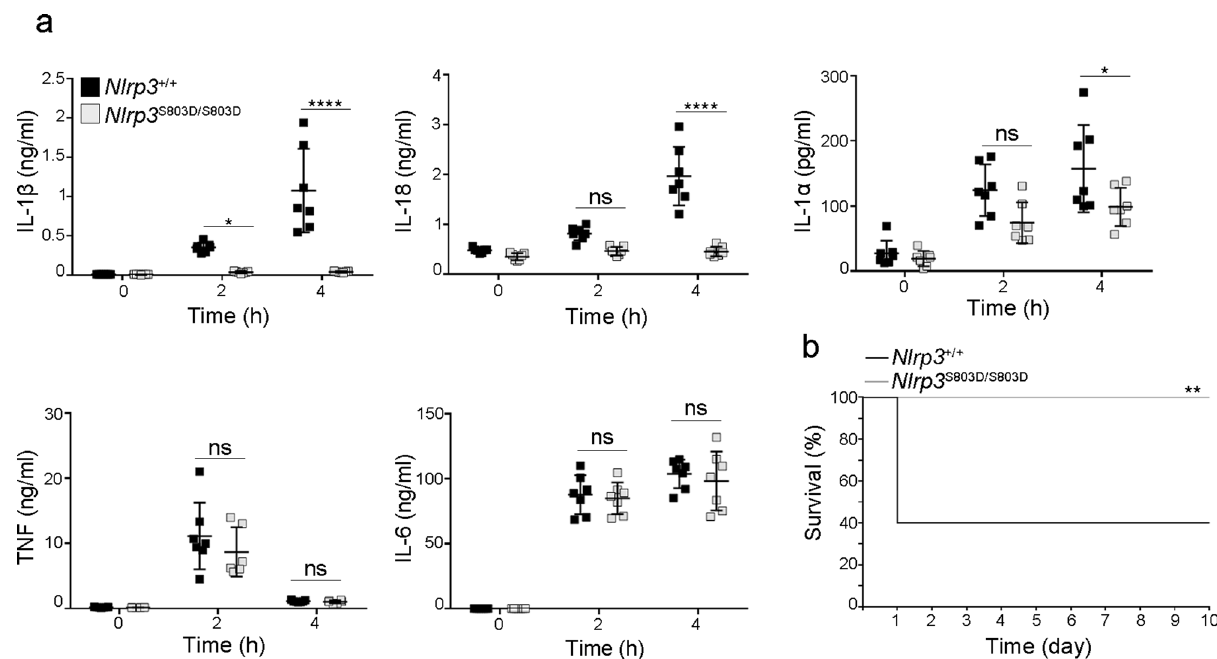
Fig. 5 S803D phospho-mimetic mutation blocks NEK7 recruitment by NLRP3. a Endogenous NEK7 immunoprecipitates from LPS-primed BMDMs treated with nigericin (30min) were analyzed for NLRP3 ( Nlrp3 + / + + beads, Nlrp3 + / + BMDM lysate incubated with A/G-beads without anti-NEK7). b NLRP3- de fi cient U937 cells reconstituted with NLRP3 mutants were treated with PMA, doxycycline, LPS, and nigericin. Endogenous NEK7 immunoprecipitates were analyzed for NLRP3 (WT + IgG, lysate of U937 expressing WT NLRP3 incubated with isotype control and A/G-beads). c , d BMDMs were treated with LPS (6h) and nigericin (30min). Endogenous BRCC3 immunoprecipitates were analyzed for NLRP3 ( Nlrp3 + / + + IgG, BMDM lysate incubated with IgG isotype control and A-beads; Brcc3 − / − , BRCC3 immunoprecipitates from Brcc3 − / − BMDM lysate) ( c ). NLRP3 ubiquitination was assessed by NLRP3 immunoprecipitation followed by anti-Ub WB ( Nlrp3 + / + + beads, Nlrp3 + / + BMDM lysate incubated with A/G-beads without anti-NLRP3) ( d ). e NLRP3- de fi cient U937 cells reconstituted with NLRP3 mutants were treated with PMA and doxycycline (2 μ g/ml, 16h) followed by LPS (5h) and nigericin (20min). Endogenous BRCC3 immunoprecipitates were analyzed for NLRP3 (WT + IgG, lysate of U937 cells reconstituted with NLRP3 WT incubated with isotype control and A-beads). f NLRP3-de fi cient U937 cells reconstituted with NLRP3 mutants were treated with PMA and doxycycline (2 μ g/ml, 16h) followed by LPS (50 ng/ml, 4 h) and MG132 (10 μ M, 40min), E-64d (20 μ g/ml, 40 min) and VX765 (2.5 μ M, 40 min) 10min before nigericin (30min). NLRP3 ubiquitination was assessed by NLRP3 immunoprecipitation followed by anti-Ub WB. Caspase-1 inhibitor VX765 was added to prevent pyroptosis. g NLRP3 WT and S806D mutant were expressed with Myc-BRCC3 in 293T cells in the presence or not of HA-NEK7. Myc-BRCC3 immunoprecipitates were analyzed for NLRP3 (IgG, lysate of 293T cells expressing NLRP3 WT, Myc-BRCC3 and HA-NEK7 incubated with isotype control and A/G-beads). h Immortalized WT and Nek7 − / − BMDMs were treated with LPS (6h) and nigericin (30min) in the presence of VX765 (2.5 μ M, 15min before nigericin). BRCC3 immunoprecipitates were analyzed for NLRP3 by WB (WT + IgG, lysates of immortalized WT BMDMs incubated with isotype control and A-beads). i , j BMDMs were treated with LPS (6h) and nigericin (30min) with oridonin (2 μ M, 30min before nigericin). Endogenous BRCC3 immunoprecipitates were analyzed for NLRP3 ( i ). NLRP3 ubiquitination was assessed by NLRP3 immunoprecipitation followed by anti-Ub WB ( j ). Data are one representative of three